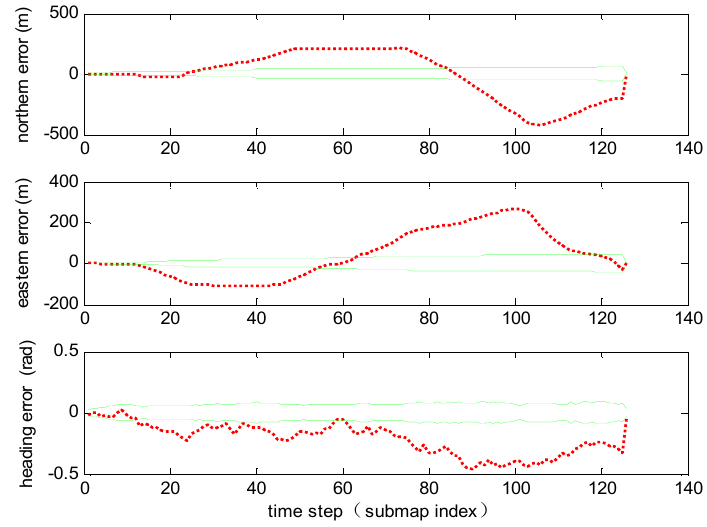
Figure 5. Error and 3 σ uncertainty bound of robot pose by using the four algorithms, where the red (dot) is errors and the green (solid) is 3 σ uncertainty